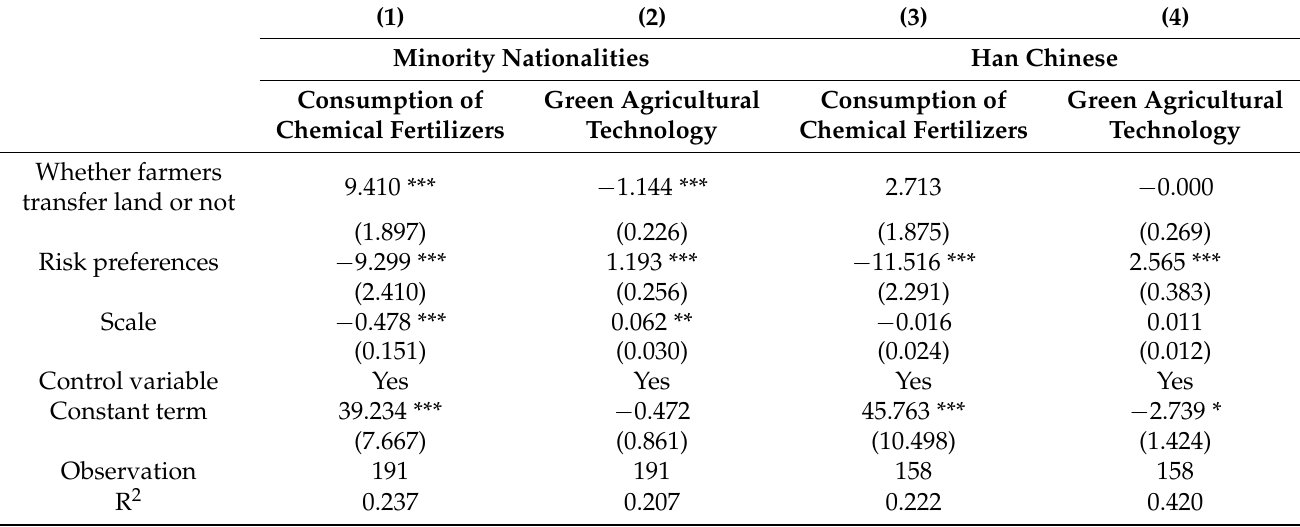
Table 6. Land transfer and farmers’ green production behavior: national